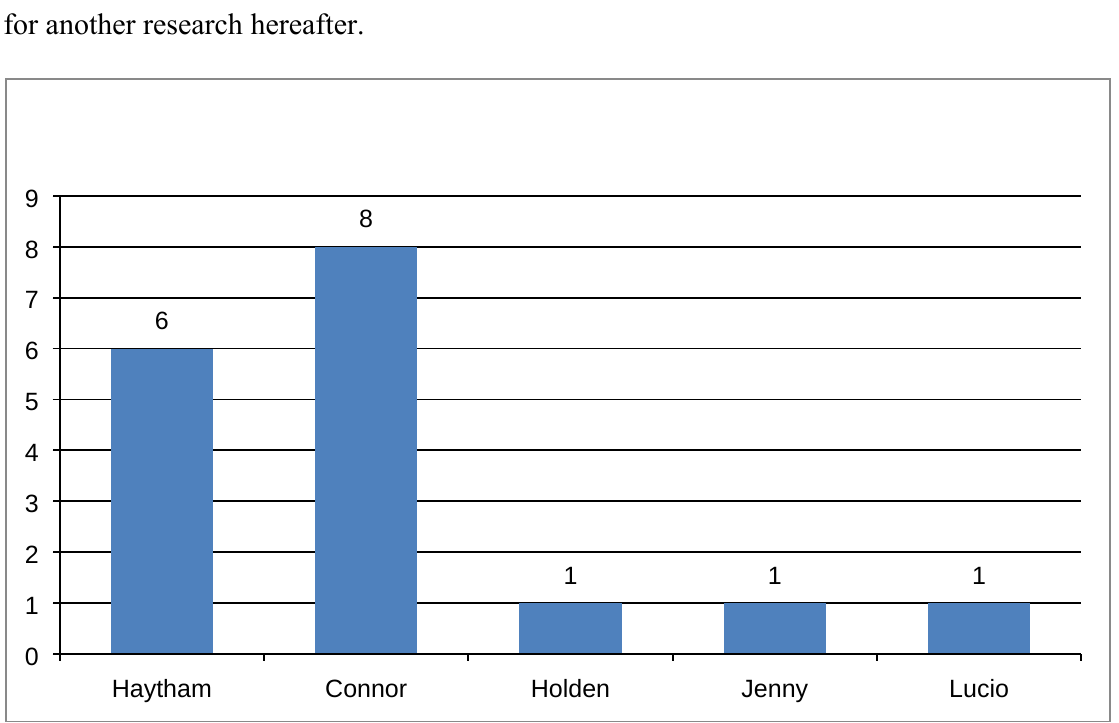
Figure 3: Characters with Most